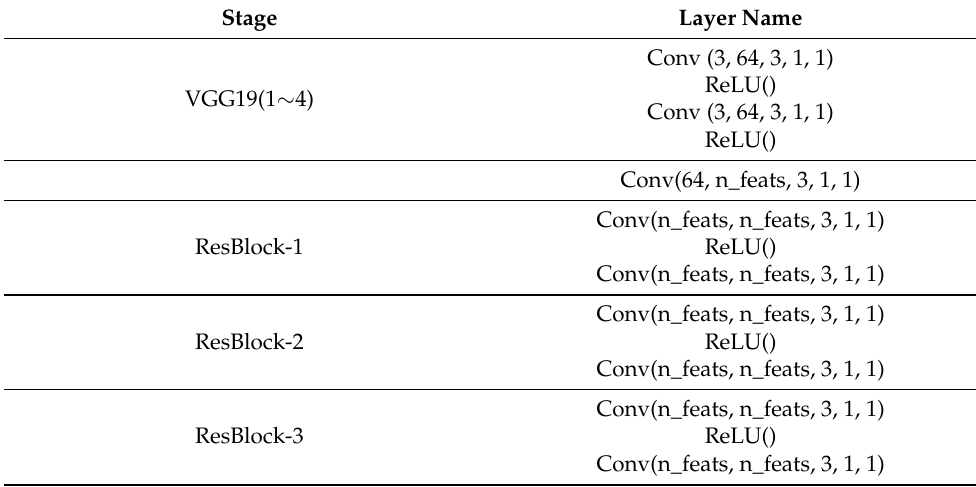
Table A1. The detailed structure of